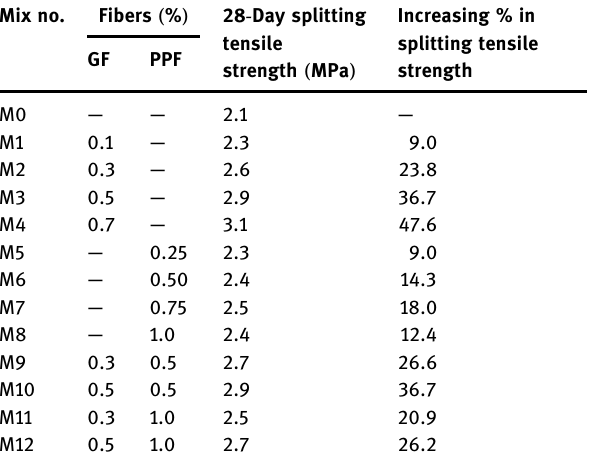
Table 13: Splitting tensile strength test results of LWC mixes Mix no.